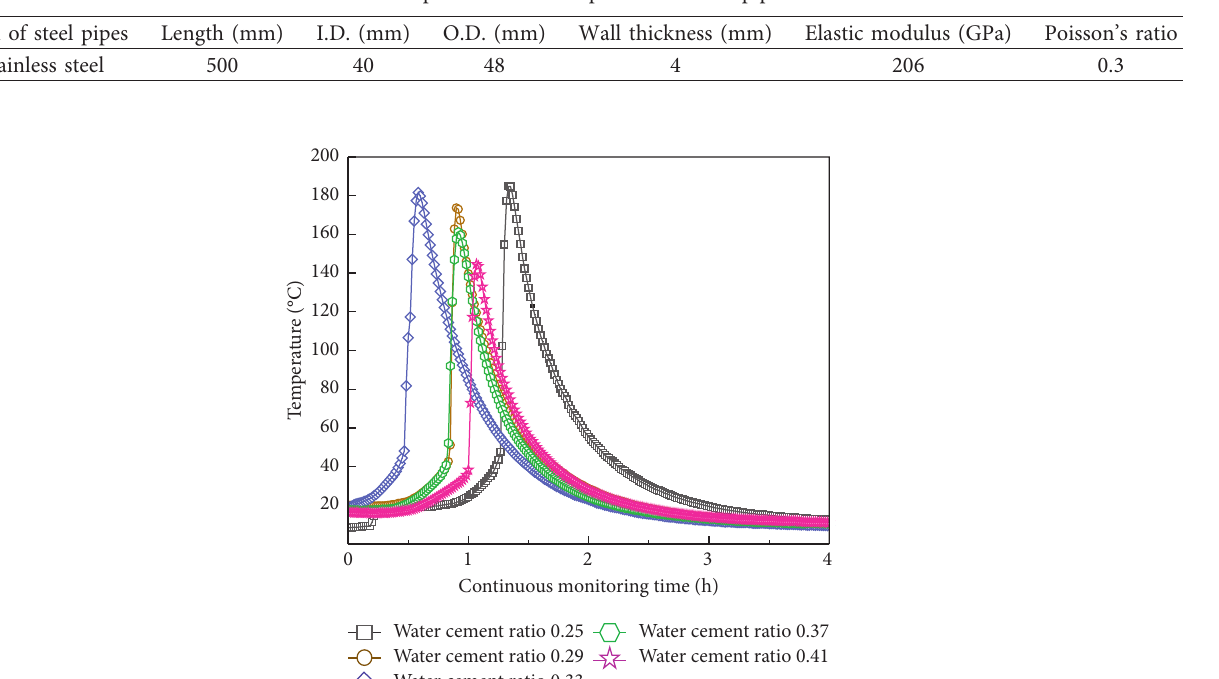
Table 3: Specifications of experimental steel pipes.